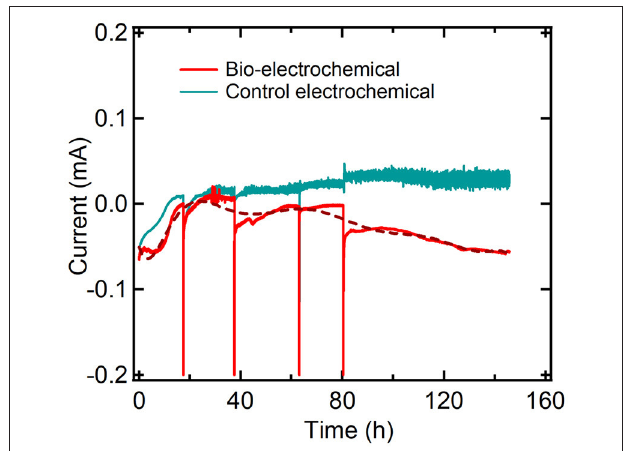
FIGURE 6 | Current evolution during bio-electrochemical and abiotic electrochemical reactions.